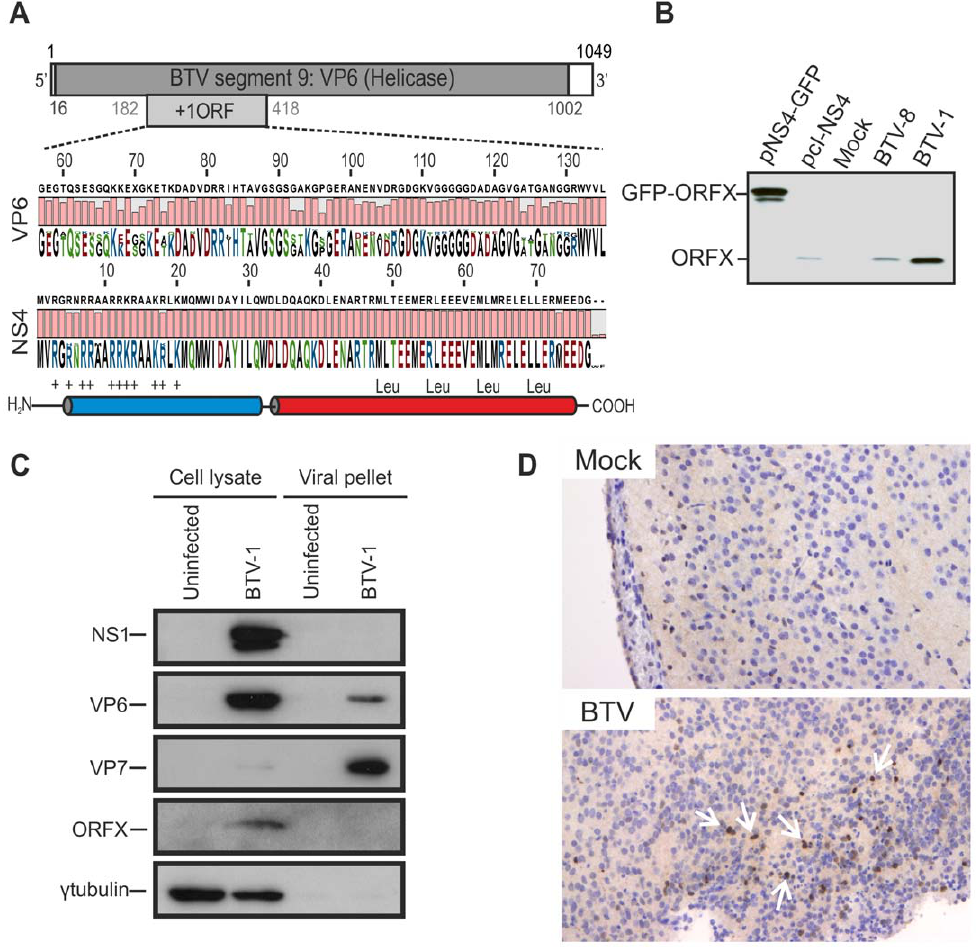
Figure 1. BTV expresses a fourth non structural protein (NS4). (A) BTV segment 9 (1049 base pairs). The VP6 protein (dark gray) is encoded by nucleotides 16 to 1002. The NS4 coding sequence is located in the + 1 open reading frame (ORF) between nucleotides 182 to 418. VP6 (residues 57 to 135) and NS4 (residues 1 to 79) amino acid conservation plots are shown. NS4 secondary structure prediction indicated the presence of two putative a -helices, drawn in blue and red. The N-terminal domain (blue) is highly basic and the C-terminal domain (red) contains a conserved leucine zipper motif. (B) Western blotting of cellular extracts (lysate) of BSR cells either transfected with 1.8 m g of plasmid expressing NS4 alone (pcI-NS4) or in fusion with eGFP (peGFP-NS4), or infected by BTV-8 or BTV-1 at a MOI of 0.01. Cells were analyzed 36 h post-transfection or infection and blots